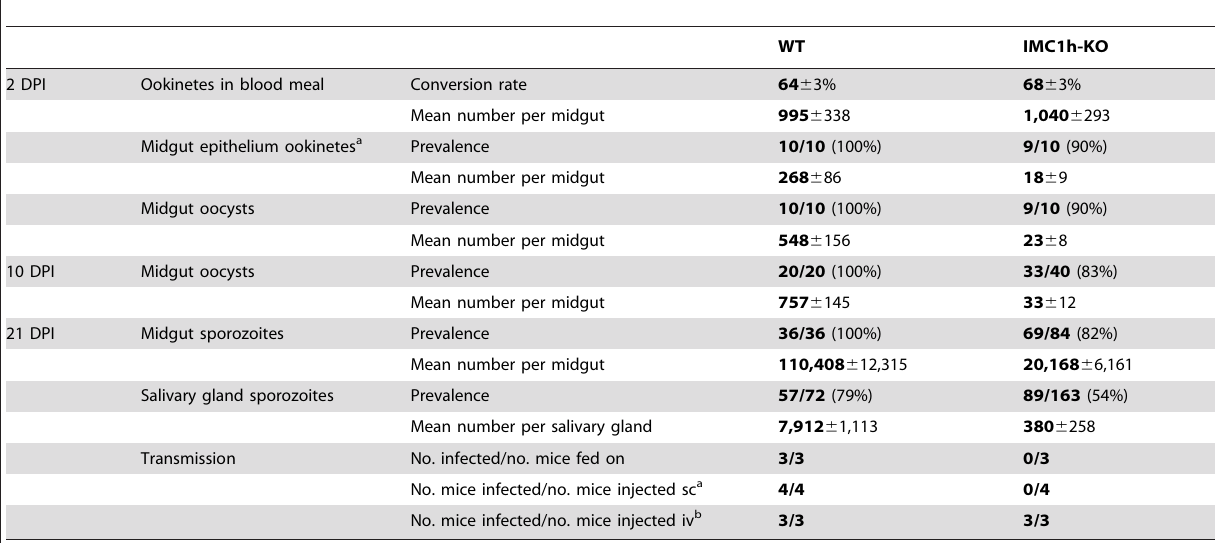
Table 1. Parasite development within the mosquito host and transmission at 2, 10 and 21 days post-infection (DPI).